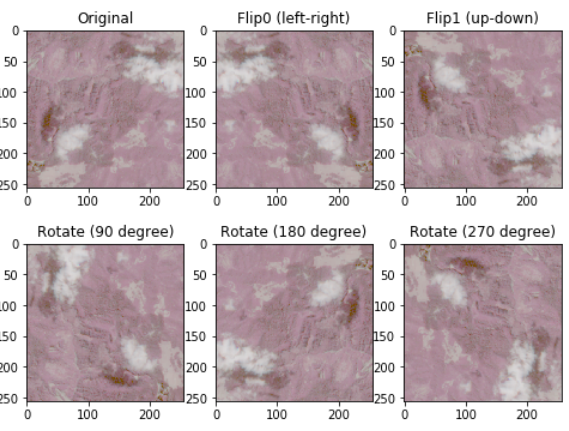
Figure 6. Splitting.